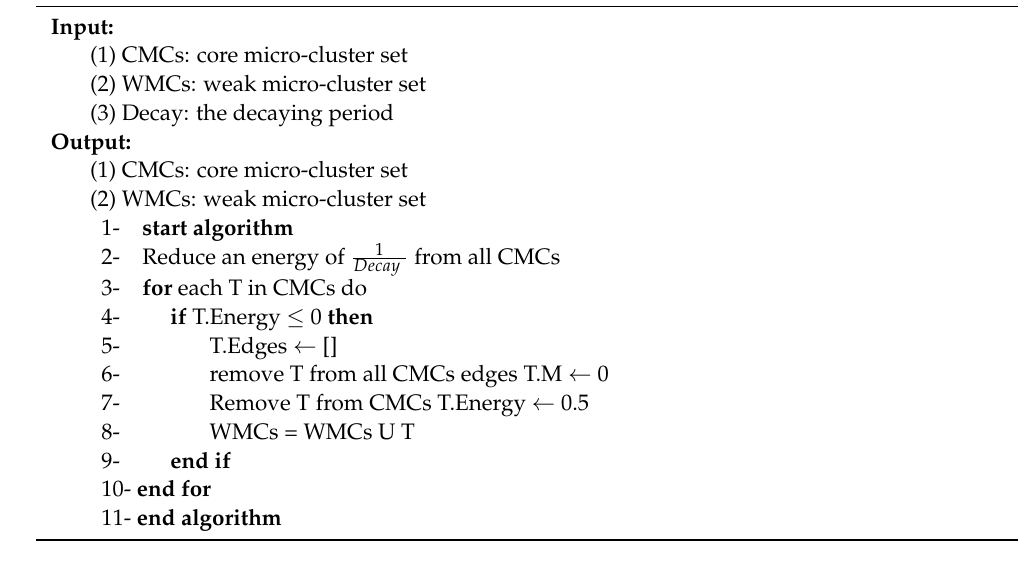
Algorithm 5: BOCEDS Moving Weak Micro-Clusters to A Buffer